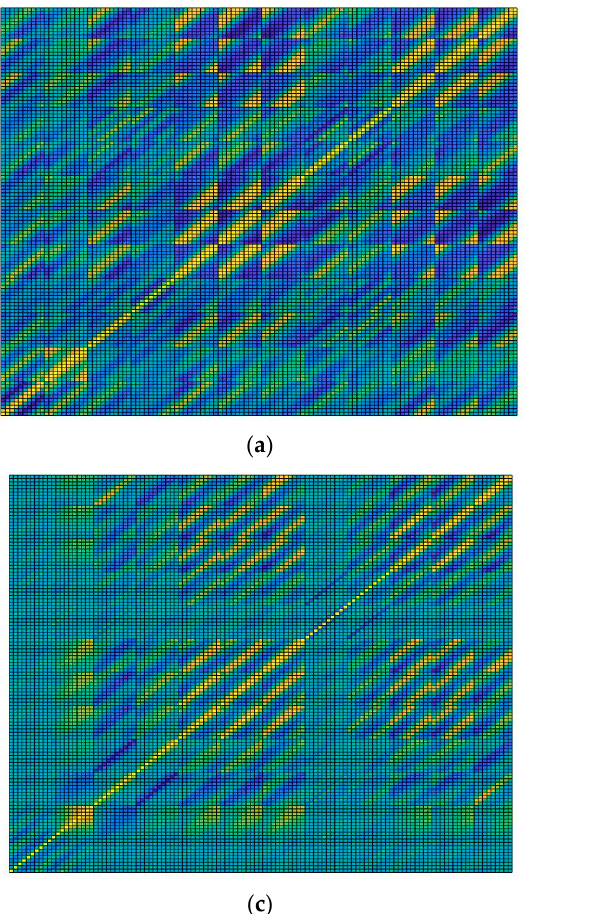
Figure 25. The correlation coefficient matrix surface plots, generated from the signals acquired with the proposed physiograph during the walking trials, for ( a ) healthy control, ( b ) Patient 5, ( c ) Patient 1, and ( d ) Patient